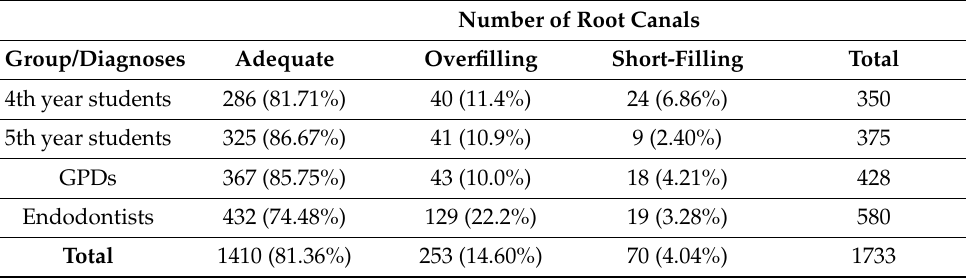
Number of Root Canals